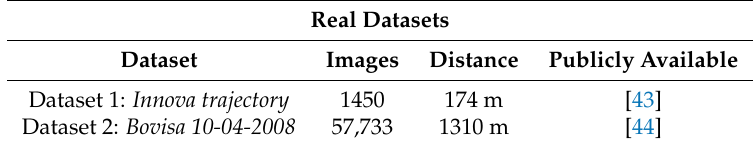
Table 2. Dataset